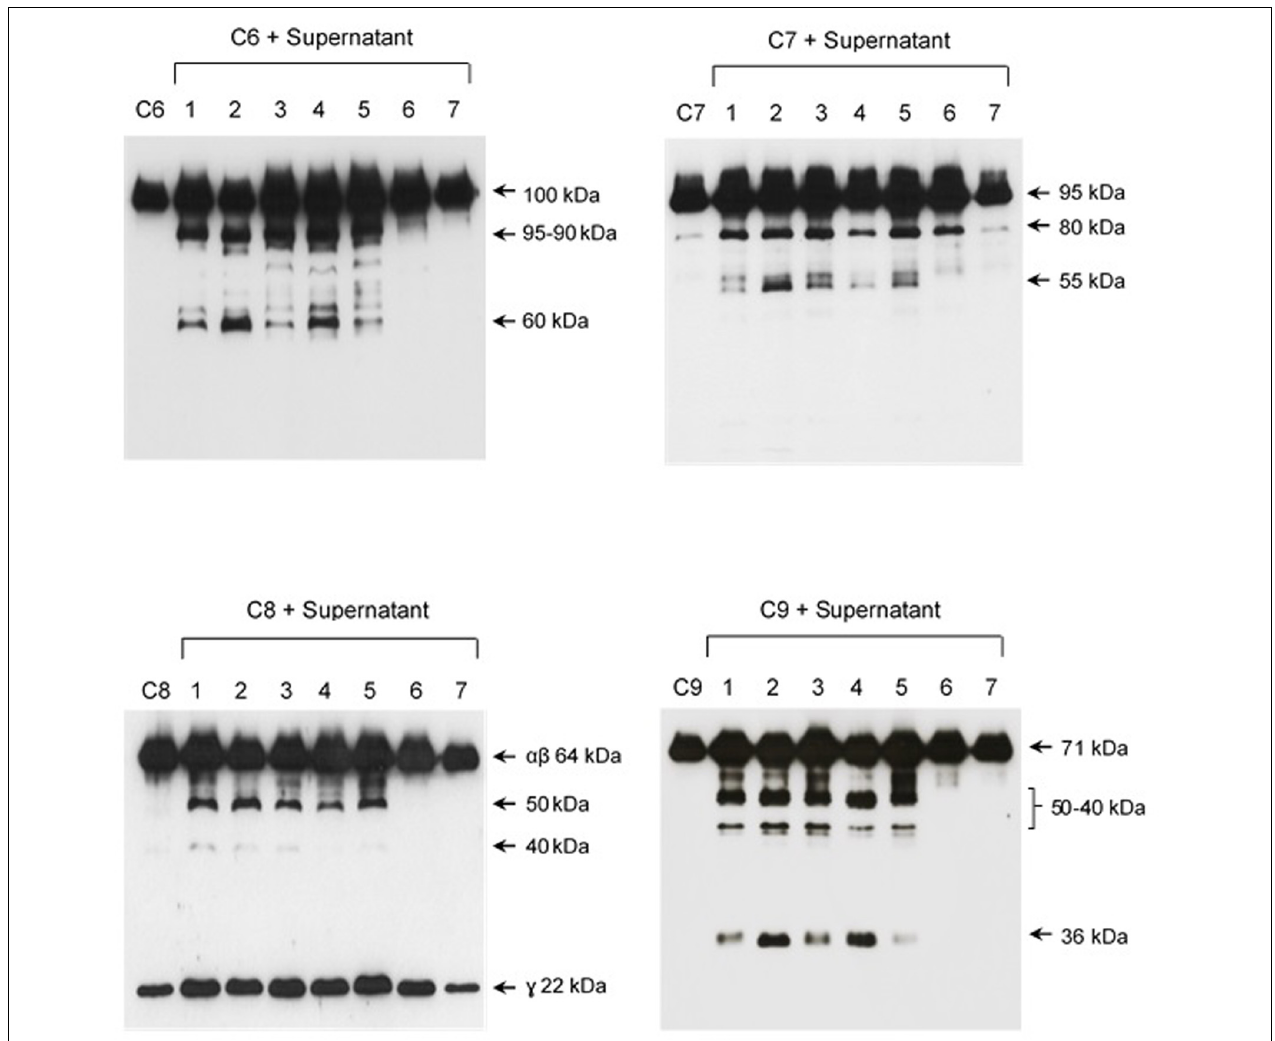
FIGURE 2 | Proteases secreted by pathogenic Leptospira cleave complement proteins C6–C9. SPL (1.5 µ g) from five different Leptospira strains (lanes 1–5) and SNPL (1.5 µ g) from two different saprophytic Leptospira strains (lanes 6 and 7) were incubated with the purified Complement proteins C6, C7, C8, and C9 (0.25 µ g each) for 1 h at 37 ◦ C. As a negative control, C6–C9 proteins were individually incubated with only PBS. Leptospira strains used: (1) L. interrogans serovar Pomona strain Pomona, (2) L. interrogans serovar Kennewiki strain Fromm, (3) L. interrogans serovar Copenhageni strain 10A, (4) L. interrogans serovar Cynopteri strain 3522C, (5) L. interrogans serovar Panama strain CZ 214), (6) L. biflexa serovar Andamana strain CH11 and (7) L. biflexa serovar Patoc strain Patoc I. The cleavages were analyzed by Western blot using specific polyclonal